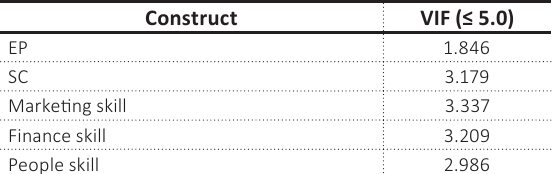
Table 3. Full collinearity assessment